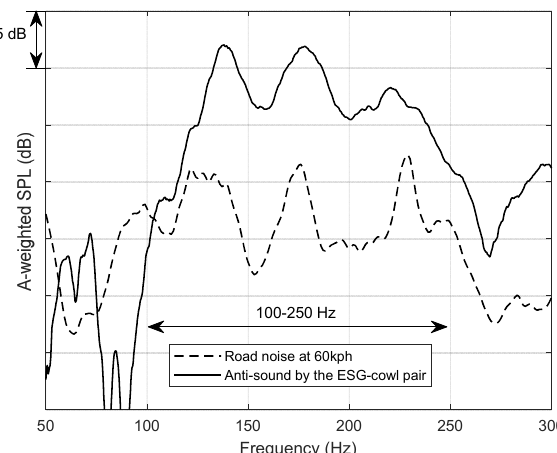
Figure 4. Comparison between the measured SPLs (at the driver’s ear position) of the road noise (dashed line) at 60 kph and the practically maximum anti-sound (solid line) by the ESG–cowl pair.